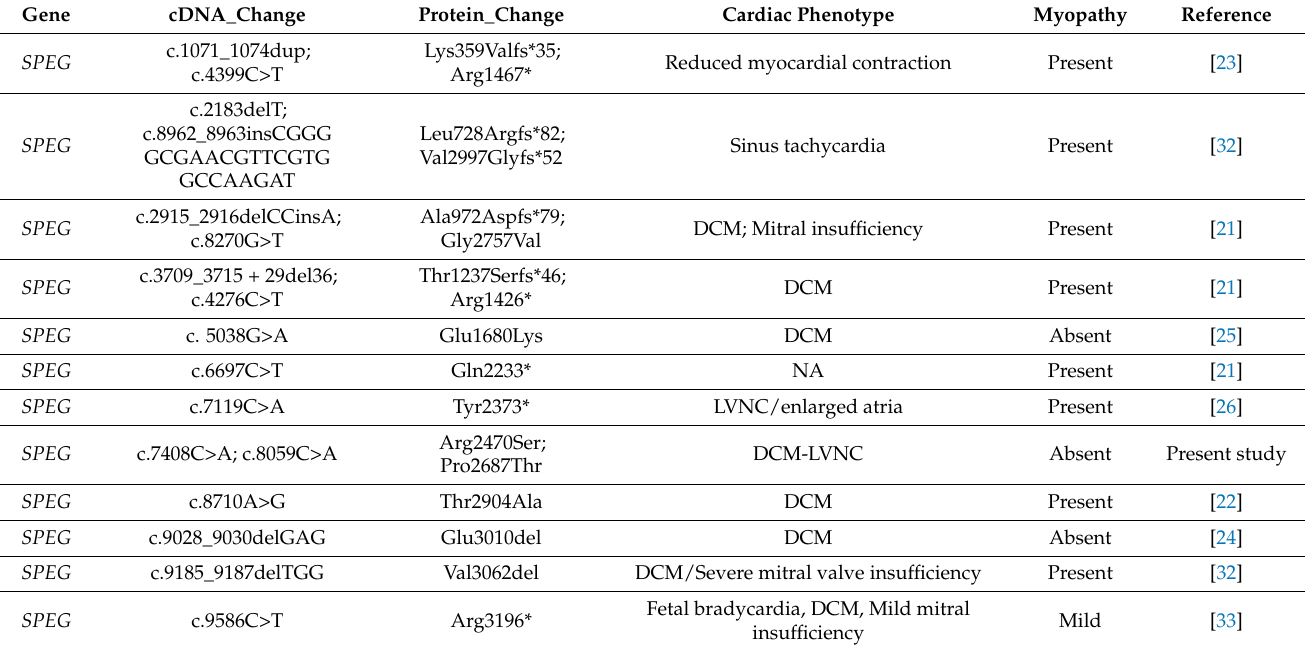
Table 1. SPEG mutations reported in patients with cardiac